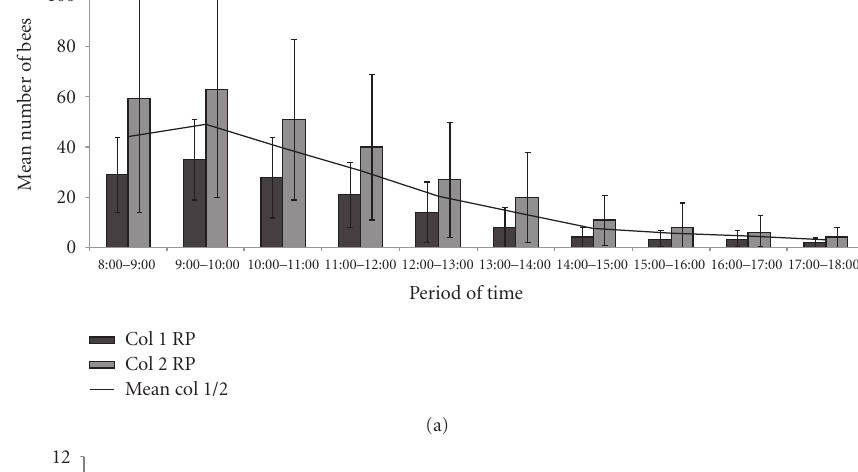
collection was greater than resin collection